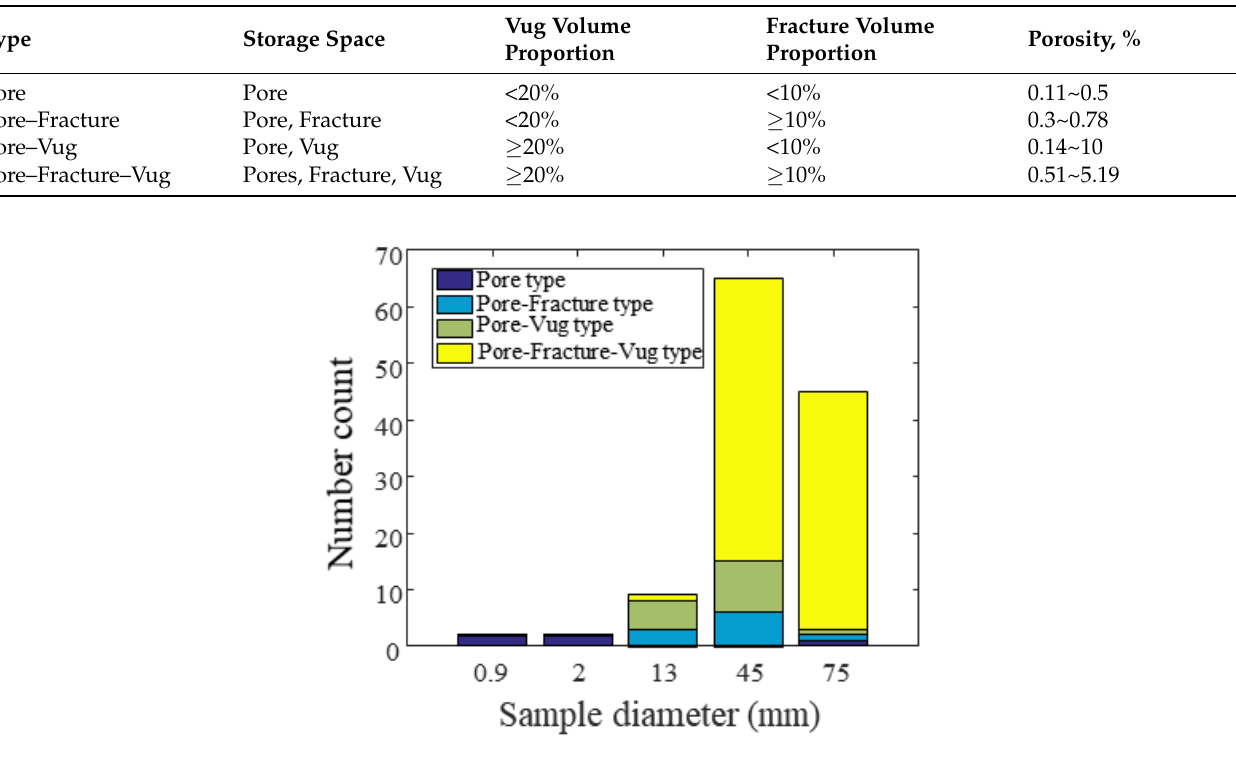
Table 1. Core type classification.